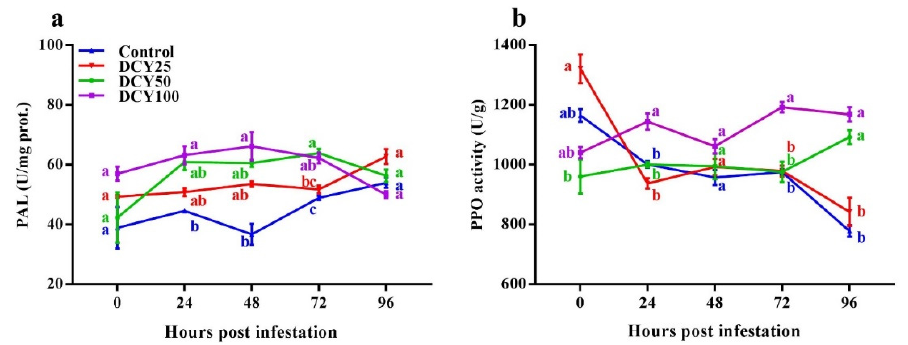
Figure 4. Activities of synthases enzymes of secondary metabolites in rice leaf sheaths in response to DCY treatment and SBPH infestation. ( a ) PAL, ( b ) PPO. Data represent means ± standard error of three replicates. Significant difference between DCY and control plants is indicated by letters (a,b,c) ( p < 0.05, Tukey’s HSD test).